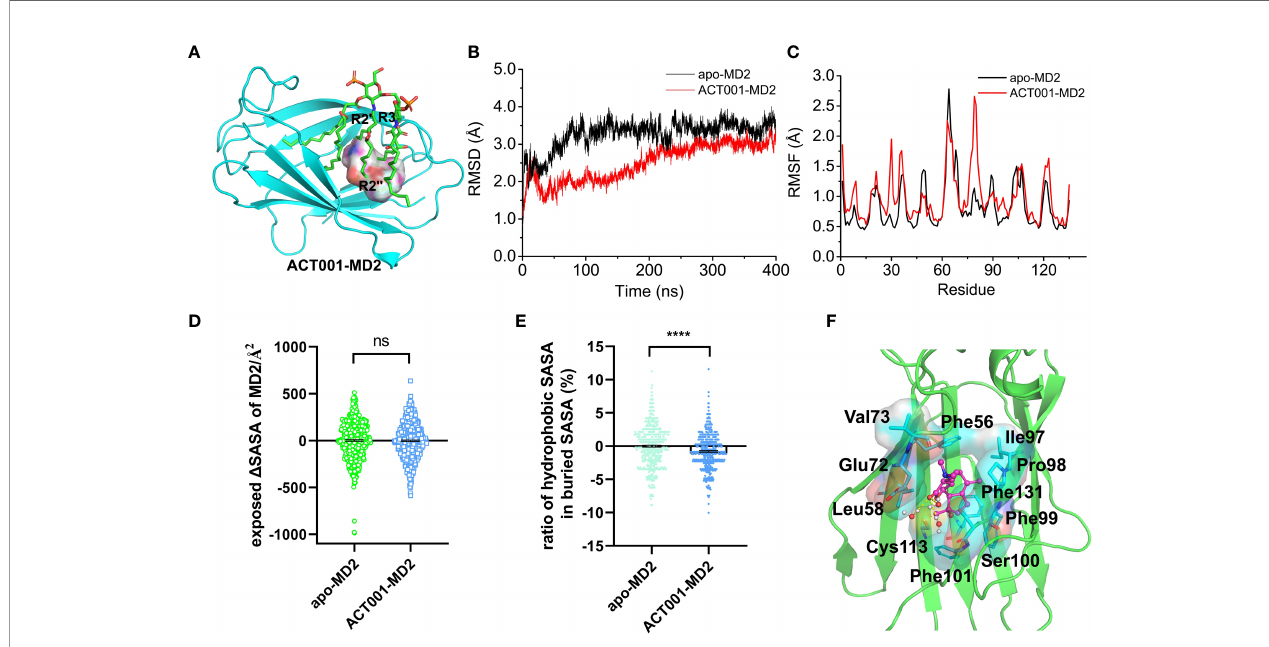
FIGURE 2 | In silico simulation of ACT001 interacting with MD2. (A) Overlap of the best docking pose of ACT001 and lipid A in MD2. ACT001 occupied the LPS binding location (acyl chains R3, R2 ’ and R2 ’’ ). Lipid A was extracted from the active state of TLR4/MD2/LPS complex (PDB ID: 3VQ2) after aligning with ACT001- docked MD2. MD2 was shown as a cyan cartoon, lipid A as green sticks, and ACT001 as surface. (B) Time evolution of the RMSD of MD2 (apo-MD2) and ACT001 bound MD2 (ACT001-MD2) during the MD simulations at 310 K. (C) Time evolution of RMSF of MD2 and ACT001 bound MD2 during the MD simulations at 310 K. (D) The changes of the exposed SASA of MD2 upon binding with ACT001. Data were calculated based on the last 20 ns equilibrated MD trajectories at 310 K. ns, not statistically signi fi cant. (E) The ratio of the hydrophobic SASA in the buried SASA of MD2. Data were calculated based on the last 100 ns equilibrated MD trajectories at 310 K ****P< 0.0001. (F) The representative binding mode of ACT001 with MD2 at 310 K after molecular dynamics simulation.ACT001 was shown as a balls-stick model. MD2 was shown as a cartoon model. Key residues of MD2 in interacting with ligands were shown as stick and surface models labeled with residue names. Hydrogen bonds were shown as dashed lines in yellow. Water molecule interacting with ACT001 was represented as a balls-stick